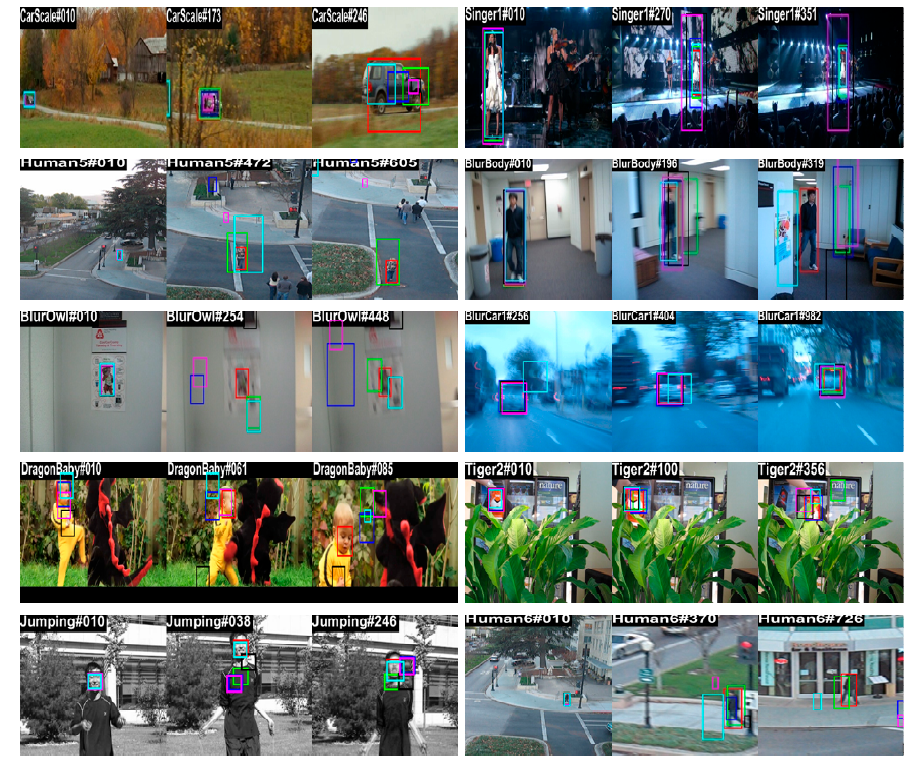
Figure 8. Qualitative results of six trackers: Ours, MUSTer, SAMF, DSST, KCF and TLD.